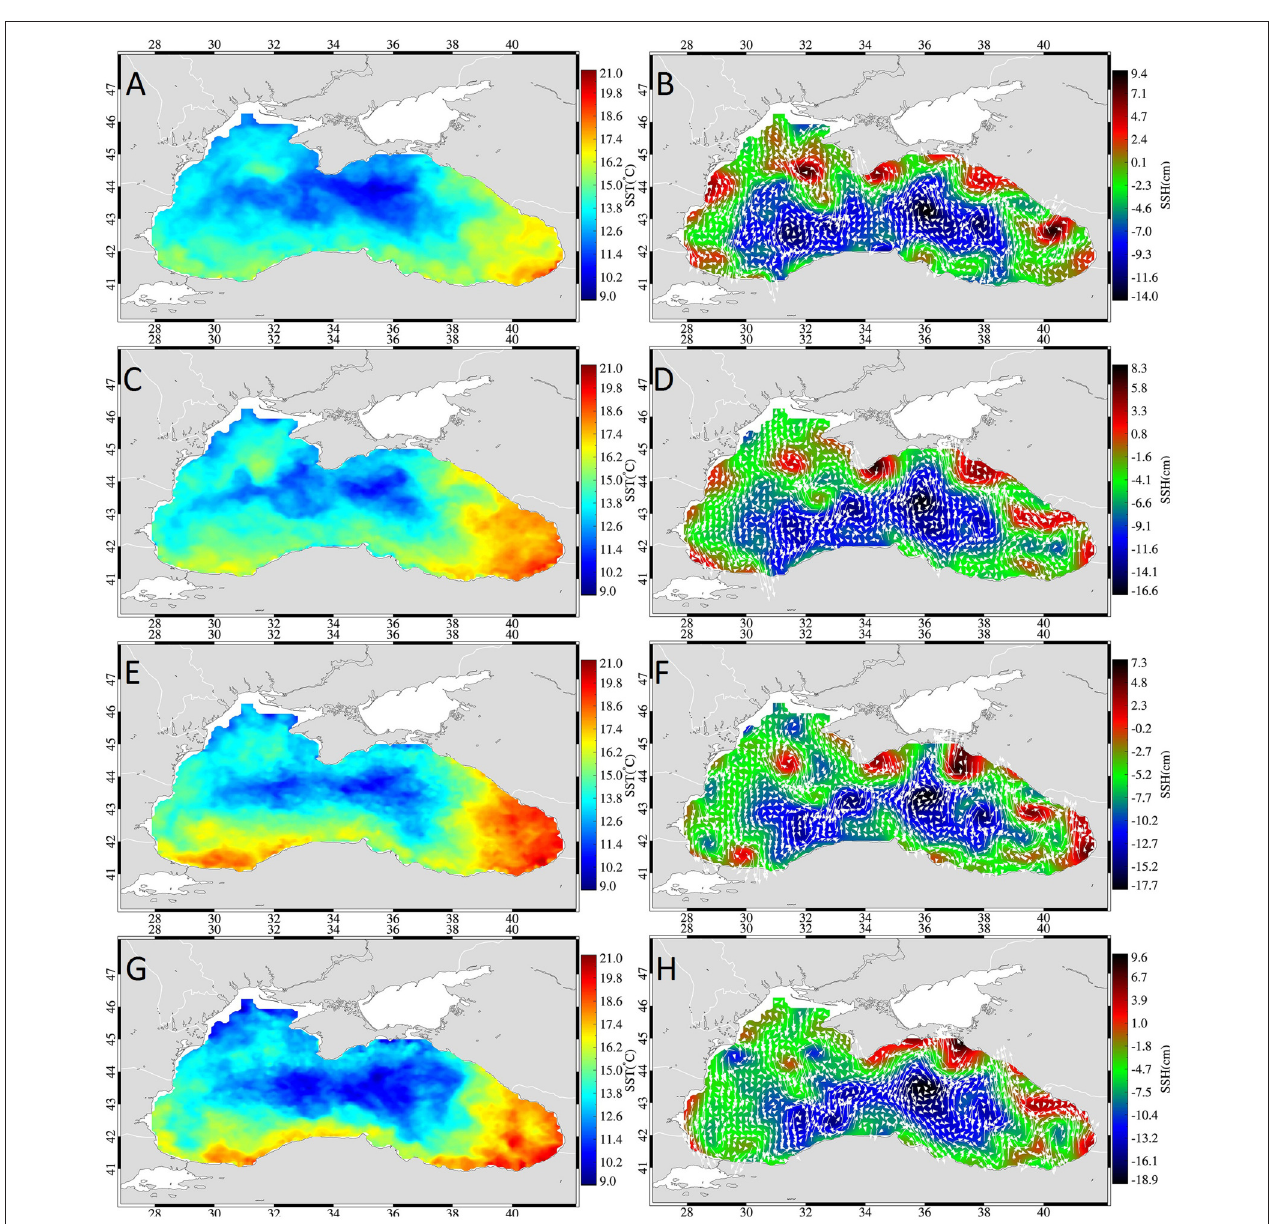
FIGURE 4 | Weekly mean sea surface temperature (left) and sea surface height fields (right) overlaid with geostrophic currents (white arrows) during week 1 (A,B) , 2 (C,D) , 3 (E,F) , and 4 (G,H) of November